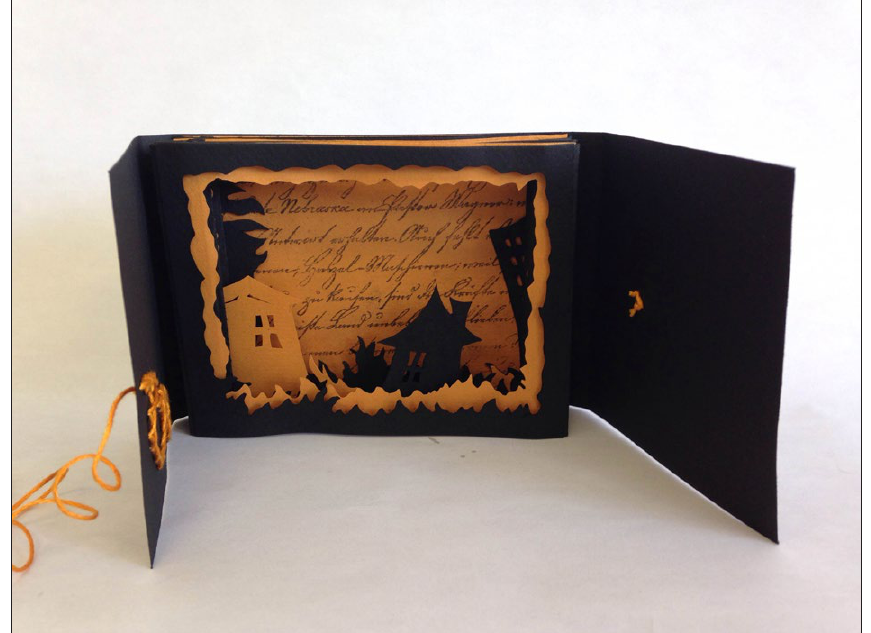
Figure 3: Rachel Epp Buller, Dear Julia, 2016, tunnel book, 3.5 × 5 inches.